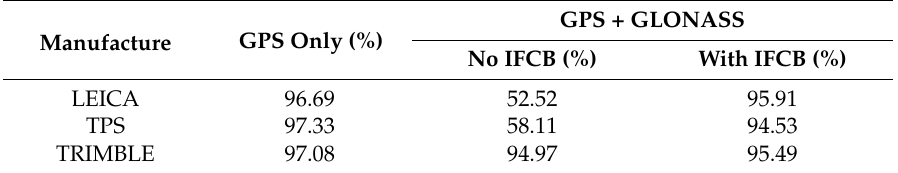
Table 3. Over-manufacturer-averaged fixing percentage of daily static PPP with various strategies.